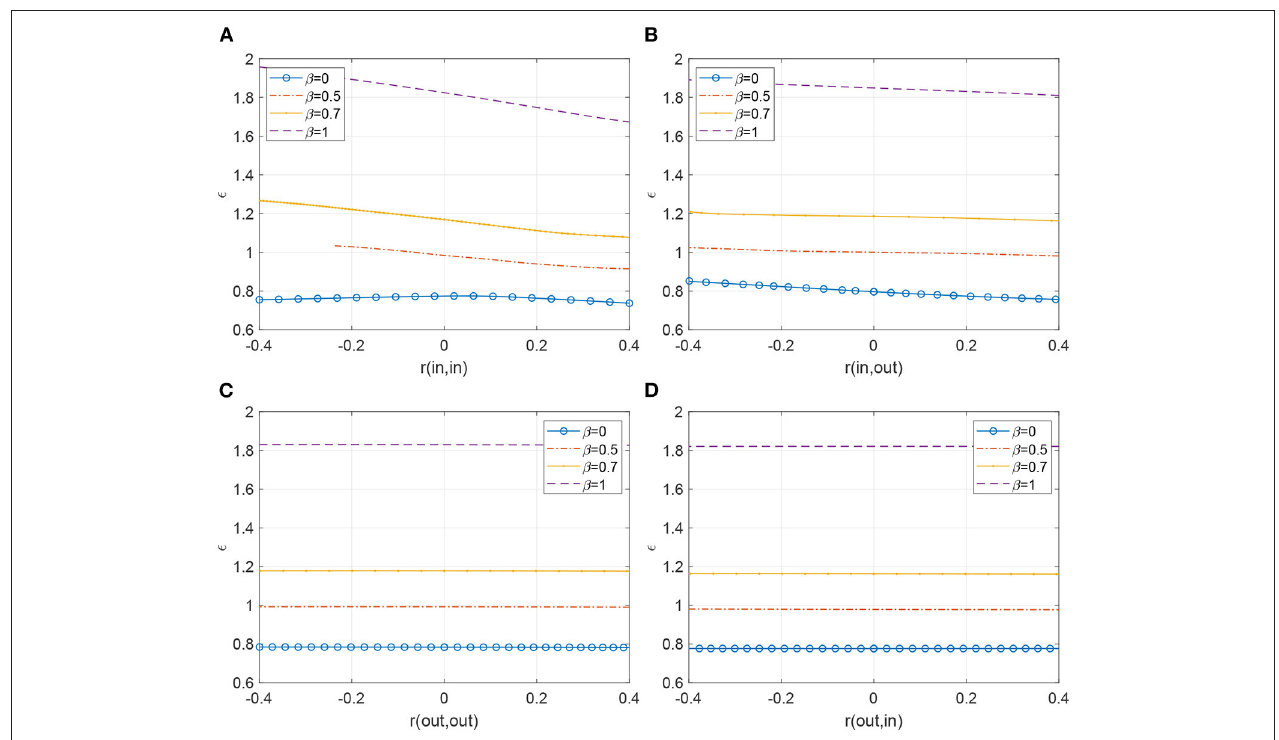
FIGURE 8 | (A–D) SNIC bifurcation curve ( β assortativity are varied. For each value of β a stable periodic orbit exists below the curve. Other parameters: 1 panel, for β 0.5 the curve terminates as r is =